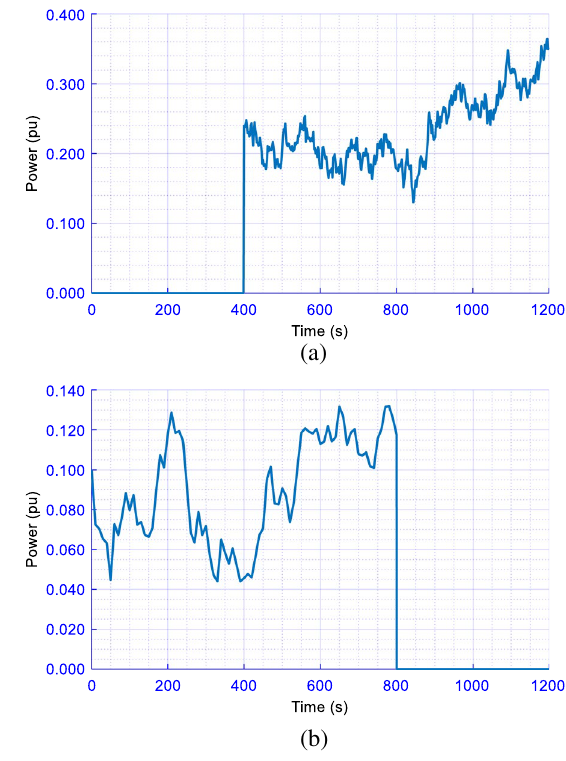
Fig. 7 Load profiles: a industrial and b residential